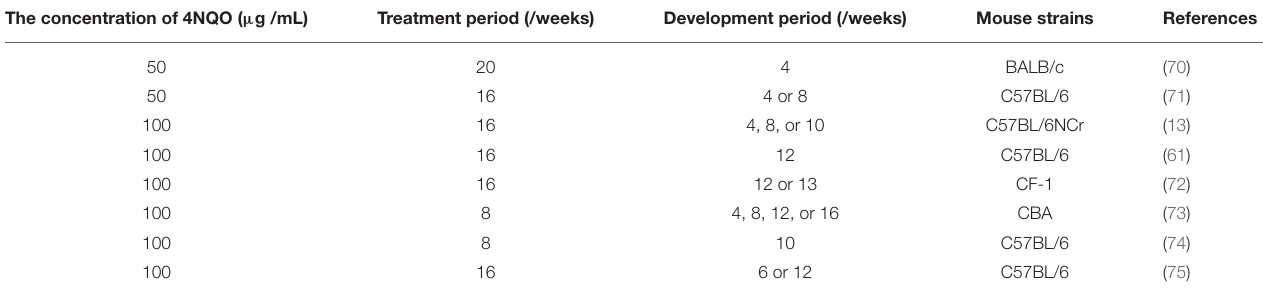
TABLE 1 | Methods of 4NQO-induced mouse models in drinking water for OSCC. The concentration of 4NQO ( µ g /mL) Treatment period